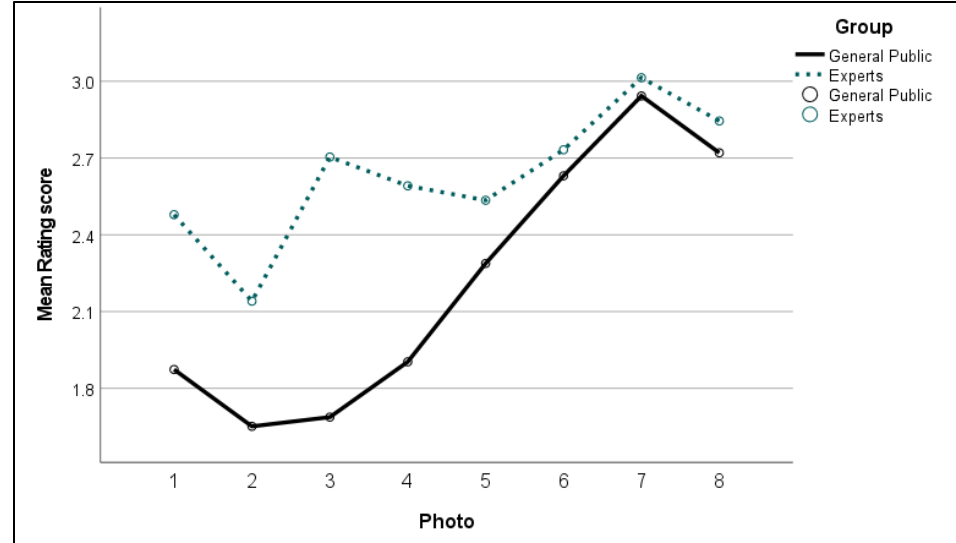
Figure 5. Mean rating scores of each context on safety.